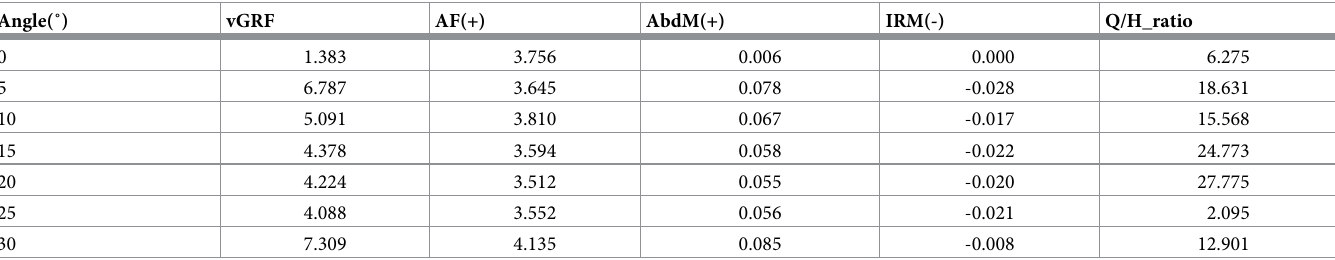
Table 8. Vertical GRF, knee JRF and JRM and Q/H force ratio at peak vGRF time instance for for multiple trunk left bending